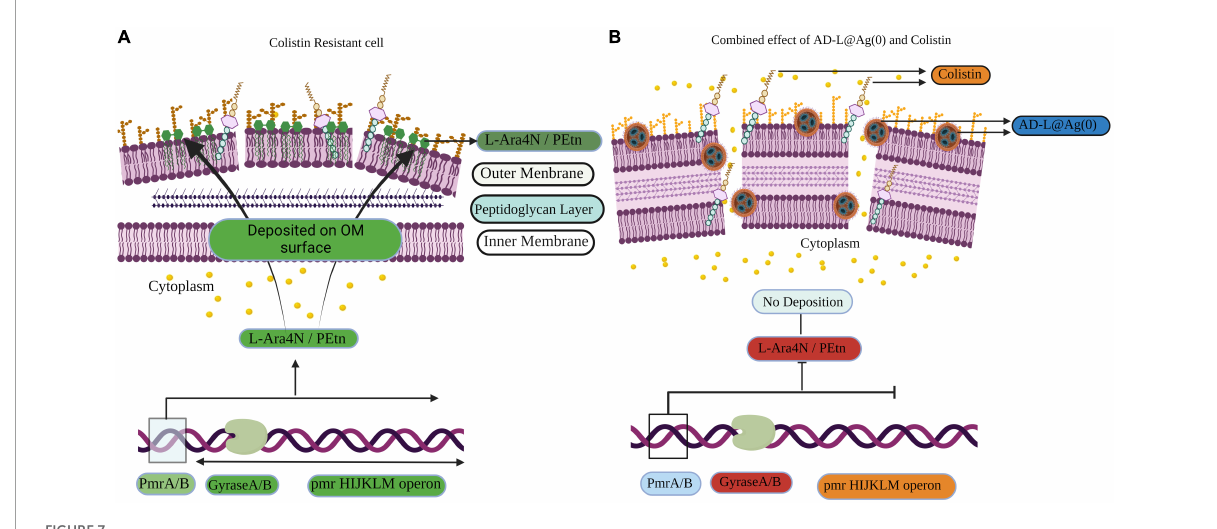
FIGURE7 Schematic representation of the induction of colistin resistance as well as reversal of colistin resistance on Acinetobacter baumanni . (A) Representation of the gene expression in colistin resistant cell: Here green color shows the upregulation of genes, e.g., GyraseA/B and pmrHIJKLM operon. pmrHIJKLM operon codes for phosphoethanolamine (PEtn) or 4-amino-4-deoxy-L-arabinose (L-Ara4N). PEtn gets deposited in the Lipid A layer, and this leads to a decrease in net negative charge, which ultimately leads to colistin resistance. (B) Representation of the gene expression in the reversal of colistin resistance when colistin + AD-L@Ag(0) combination is used: Here, it is shown how AD-L@Ag(0) affects GyraseA/B activity, which leads to inhibition of pmrHIJKLM operon. Red color shows the downregulation of genes GyraseA/b genes when the combination was used. GyraseA/B are important for negative supercoiling during processes like DNA replication, transcription, and translation. Hence, its downregulation ultimately hinders the expression of pmrHIJKLM operon. So, there is no PEtn or L-Ara4N production and there is no change in Lipid A composition and net charge present on OM. This leads colistin and AD-L@Ag(0) to exert their bactericidal effect by disrupting the cell membrane, which leads to cell